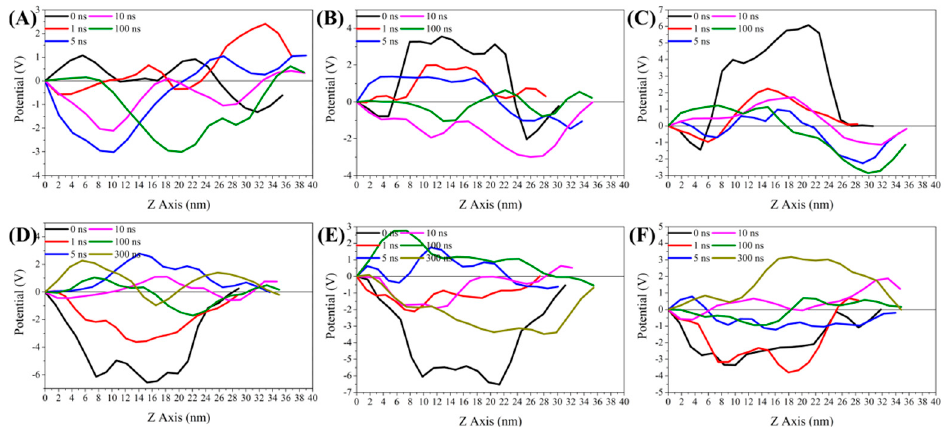
Figure 5. The variation curve of the Z axis potential difference in the interaction of the ε -PL, whey protein, and the whey protein- ε -PL complexes with the Gram-positive bacteria bilayer membrane model. ( A ) POPE/POPG. ( B ) α -La-POPE/POPG. ( C ) β -Lg-POPE/POPG. ( D ) ε -PL-POPE/POPG. ( E ) ε -PL- α -La-POPE/POPG. ( F ) ε -PL- β -Lg-POPE/POPG.